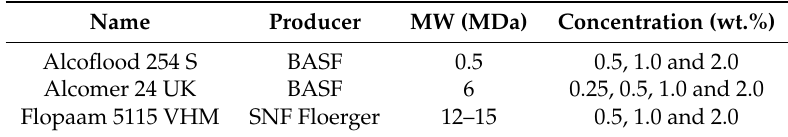
Table 1. Polymers used in the experiments.